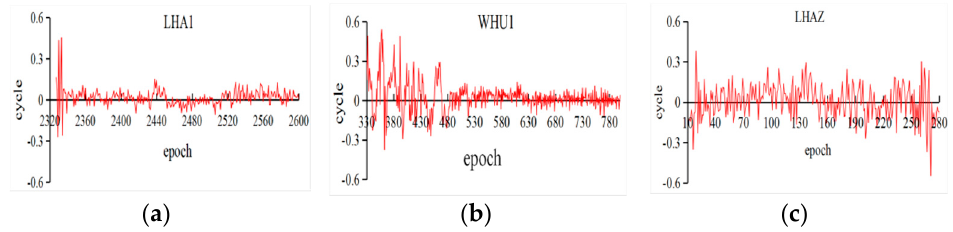
Figure 2. Time series of the fractional parts of L 2 observations for G01 on DOY 183 (( a ) LHA1; ( b ) WHU1; and ( c ) LHAZ).